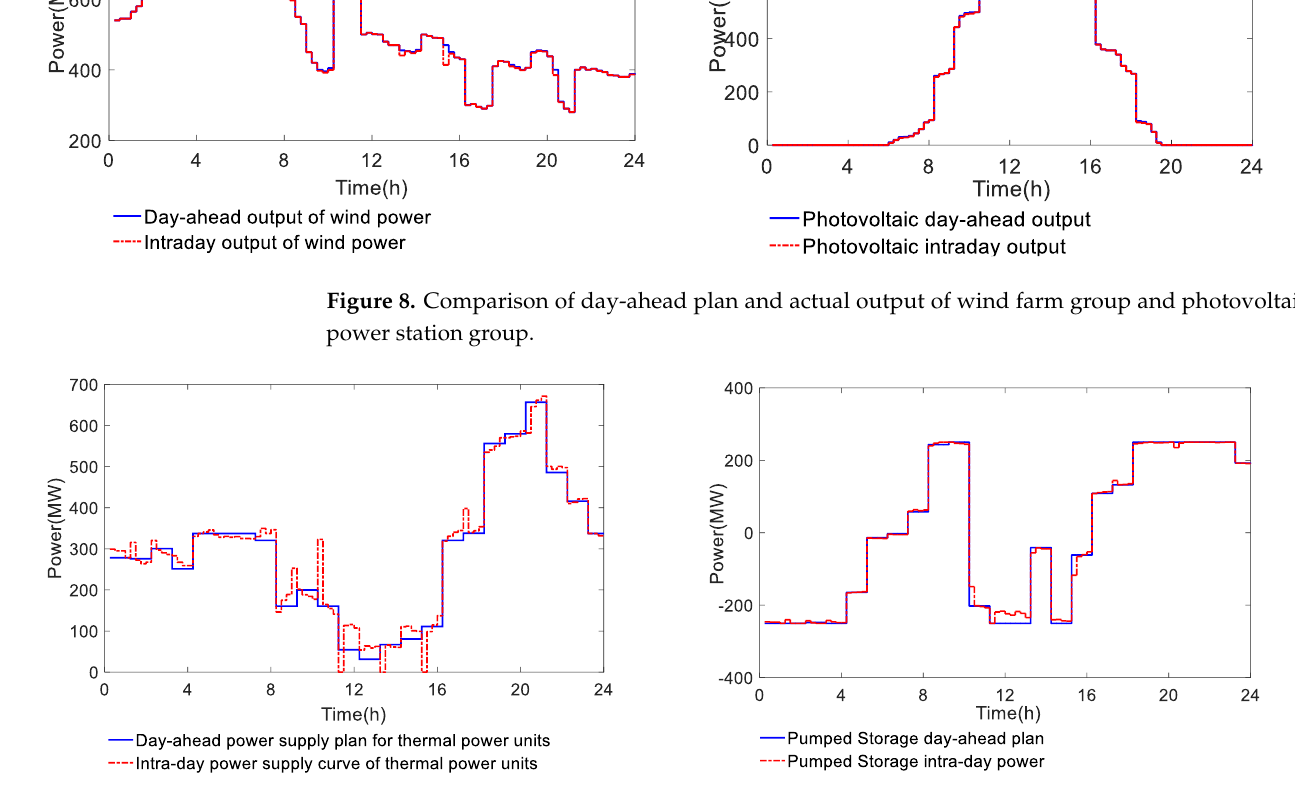
Figure 9. Comparison between current plan and actual output of thermal power unit and pumped storage unit.